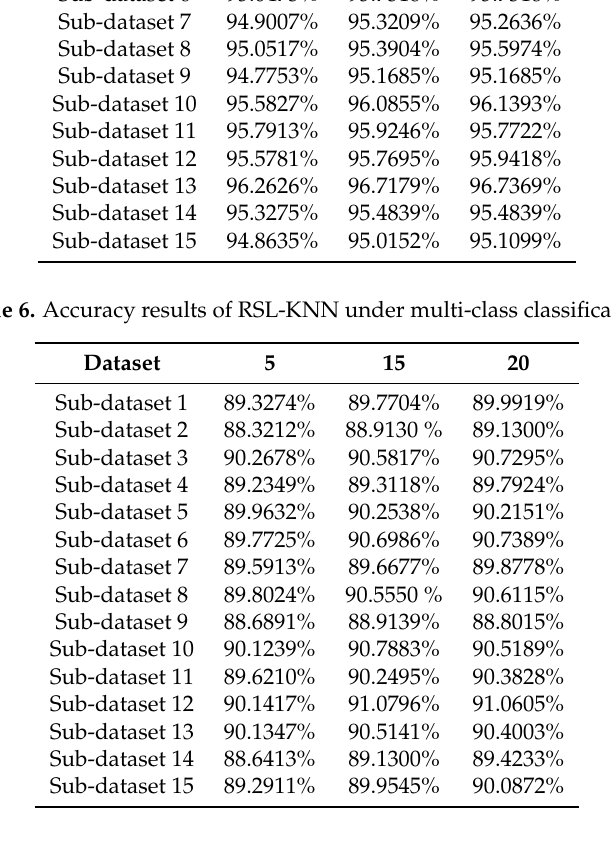
Table 7. False positive rate of RSL-KNN under binary and multi-class